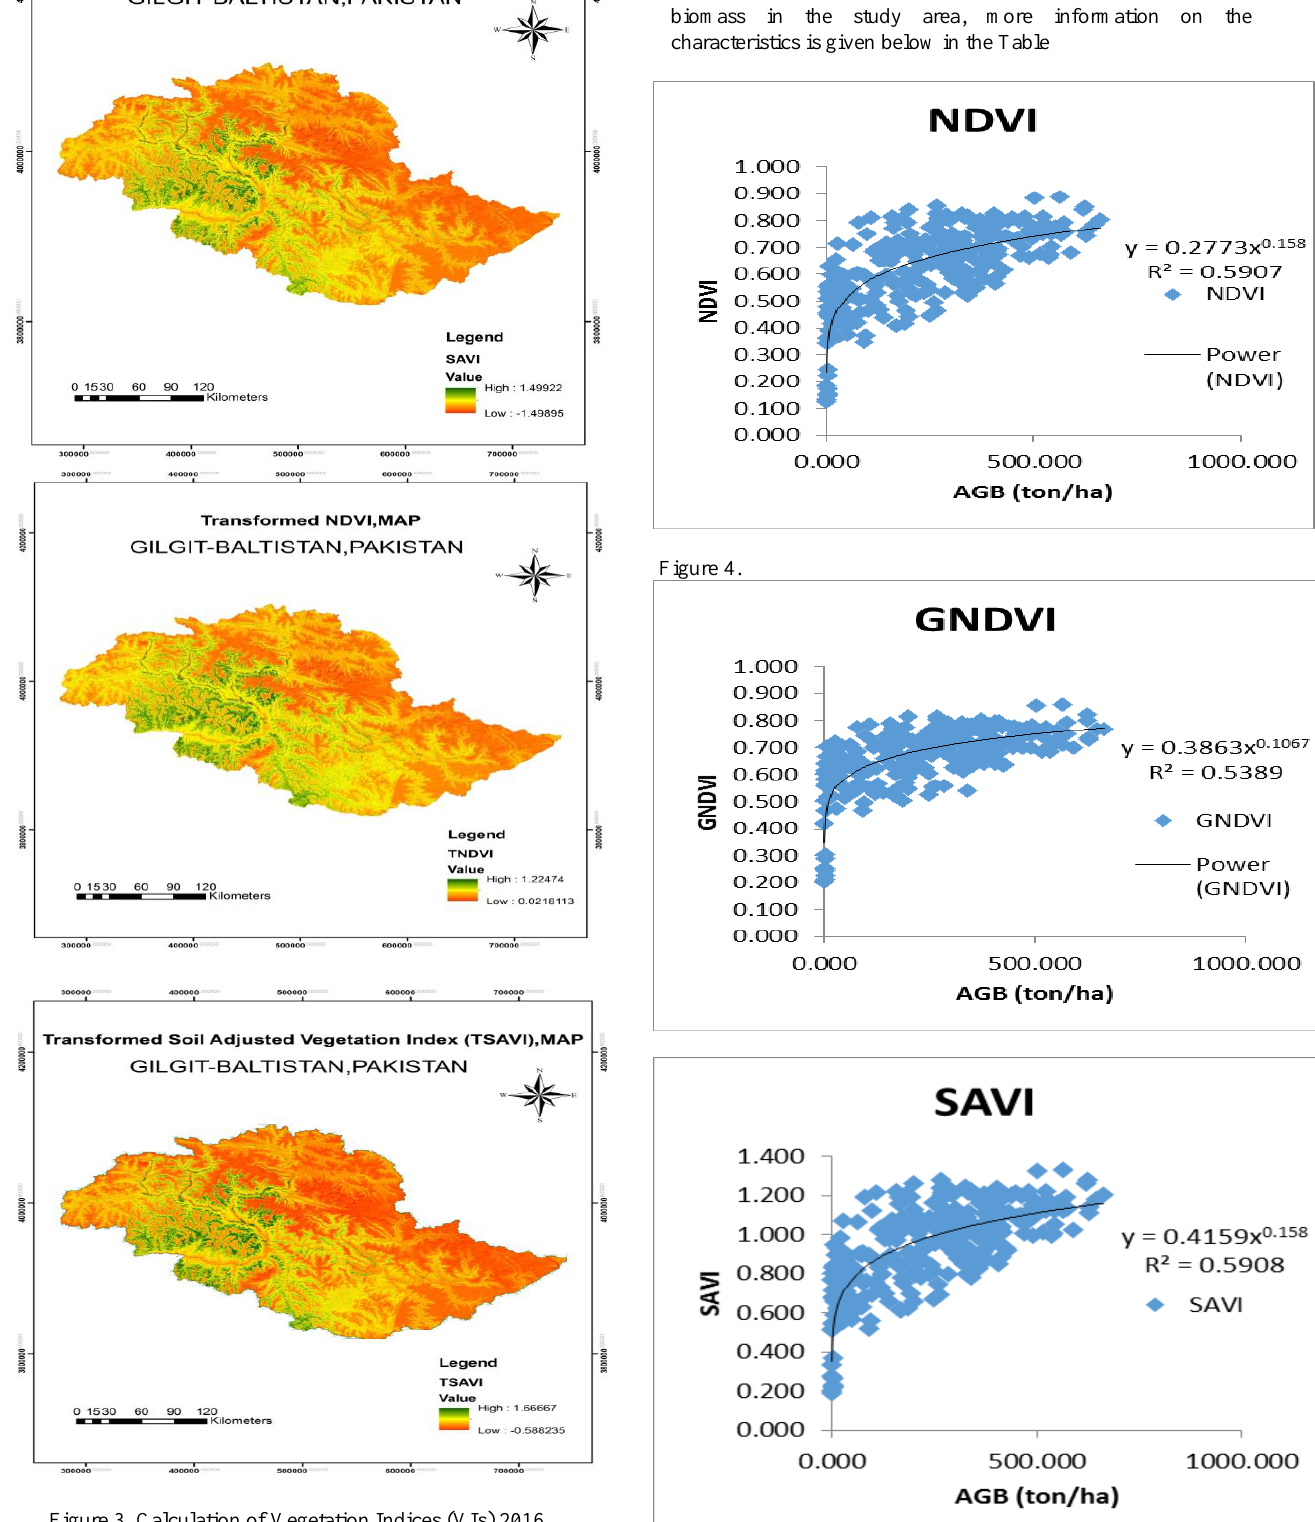
Figure 3. Calculation of Vegetation Indices (VIs)